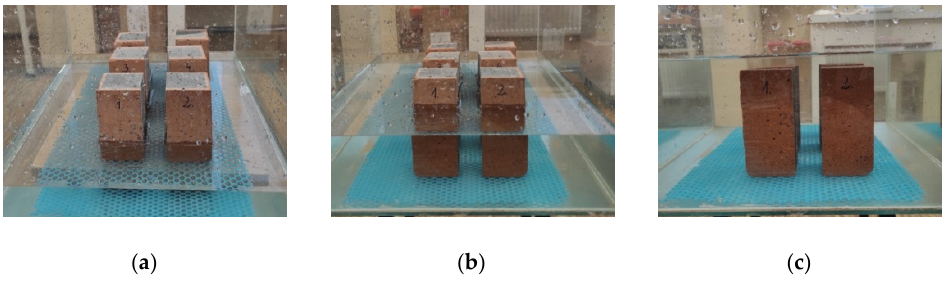
Figure 4. Water soaking stages: ( a ) stage I, ( b ) stage II, ( c ) stage III. The samples were kept in water until their constant weight was established. For weighing, samples were taken out individually and drained from water.